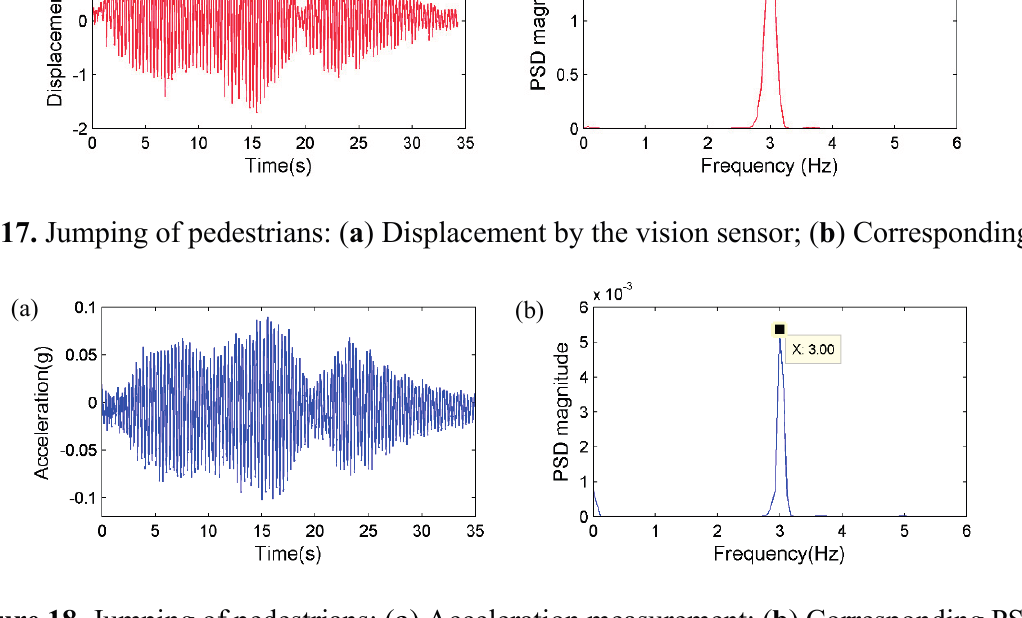
Figure 18. Jumping of pedestrians: ( a ) Acceleration measurement; ( b ) Corresponding